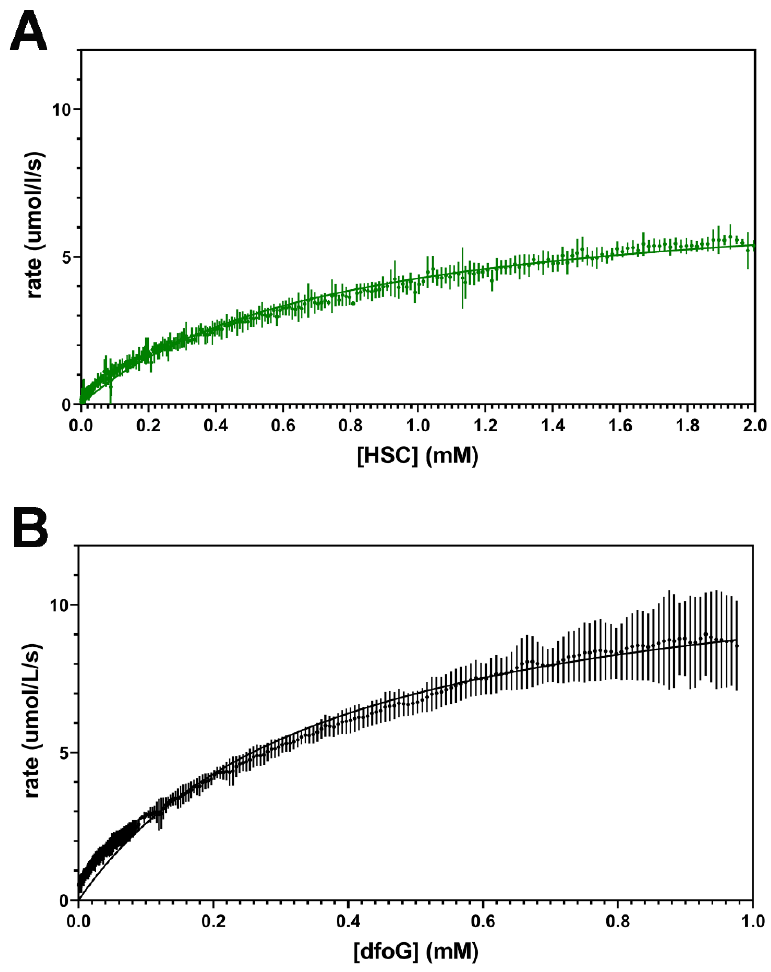
Figure 2. Comparative Michaelis-Menten kinetics of DesD catalytic turnover of dfoE from HSC ( A , in green) versus dfoG 1 ( B , in black, data previously reported [30]). Continuous calorimetric data was ascertained from a single injection of wt DesD at 1 µM concentration into a cell containing 2 mM HSC/10 mM ATP or 1 mM dfoG 1 /5 mM ATP. Each data point represents the average (small cross) and standard deviation (vertical lines) of three replicate trials, and for clarity, every other data point is shown. Data were analyzed in GraphPad Prism 8.2.